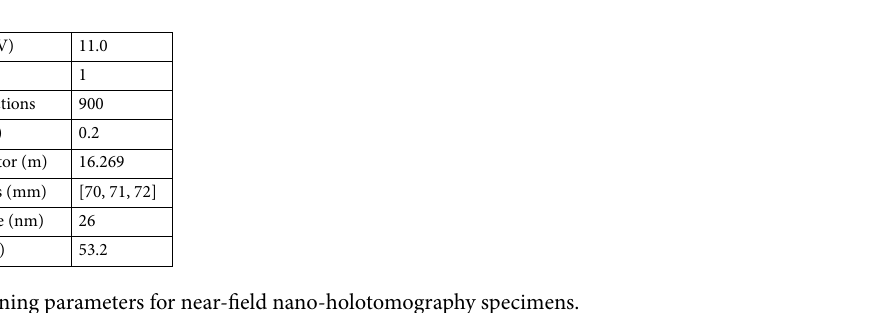
Table 1. Scanning parameters for near-field nano-holotomography